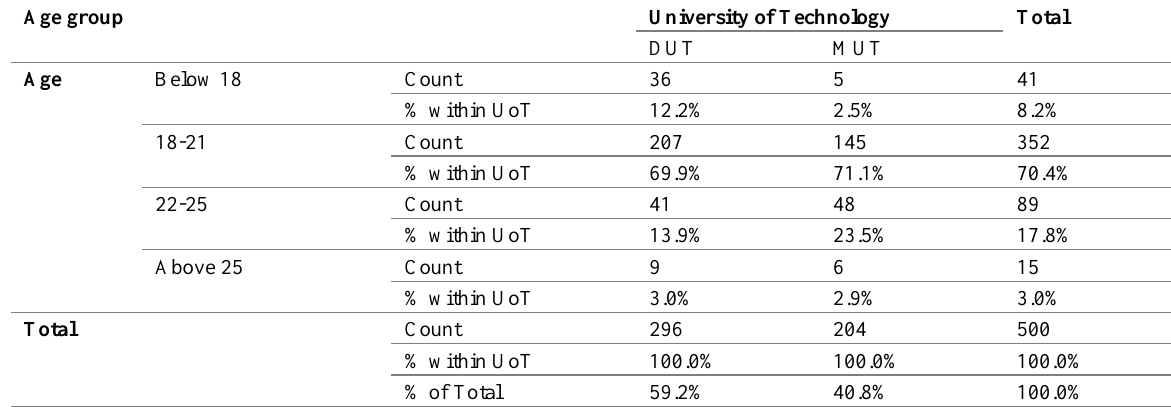
Table 3: Age group by